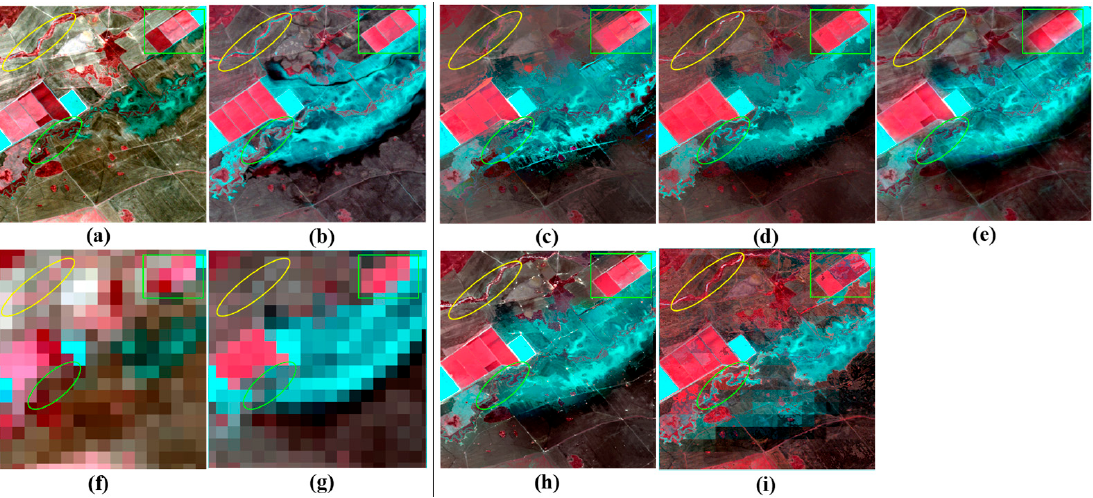
Figure 6. Zoomed-in area (green rectangle area in HR 0 of Figure 3b) of Landsat and MODIS image pairs at base date t 1 ( a , f ) and prediction date t 2 ( b , g ), as well as the simulated Landsat-like images predicted by Fit-FC ( c ), FSDAF ( d ), one-pair learning ( e ), STARFM ( h ) and UBDF ( i ).